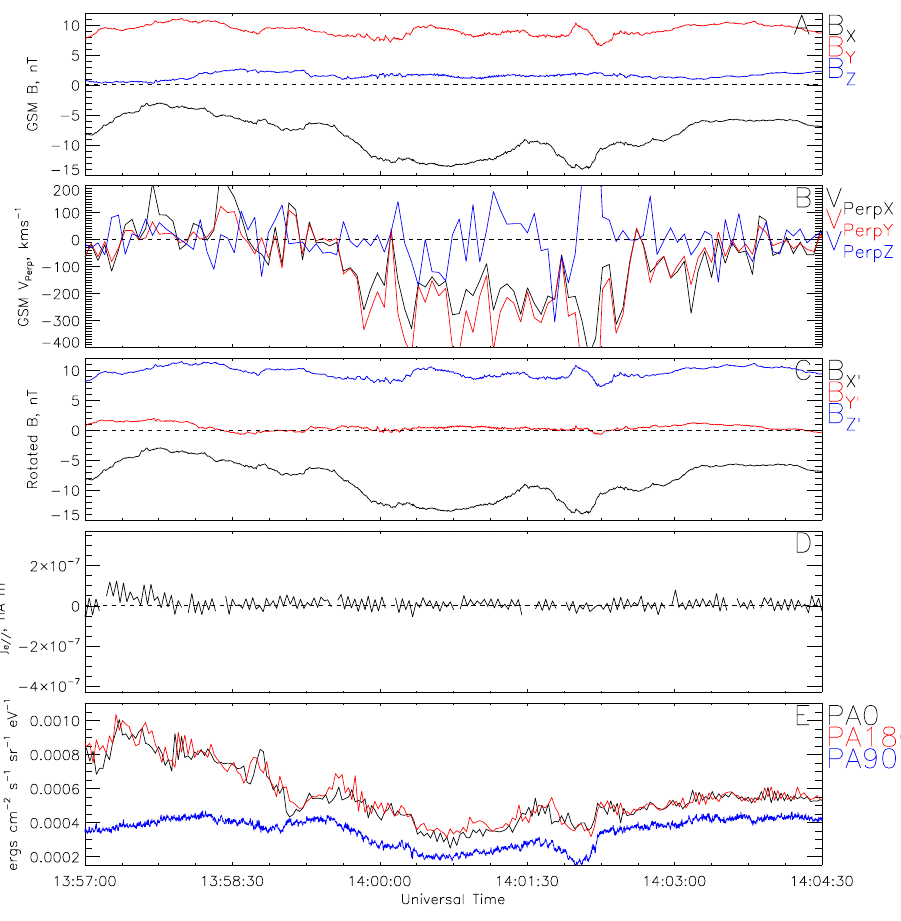
Fig. 13. A more detailed examination of the PEACE data for C2. Panel (A) shows GSM components and magnitude of magnetic field, panel (B) the GSM components of V ⊥ , panel (C) the magnetic field rotated about GSM X into a coordinate frame that eliminates any Y component in the undisturbed magnetic field, included here for completeness. Panel (D) is the parallel electron current calculated from 2-D pitch angle distributions in the energy range covered by both PEACE sensors. Panel (E) shows the electron differential energy fluxes separately for 0 ◦ PA, 180 ◦ PA and 90 ◦ PA, taken from 3-D distributions returned by both the HEEA and LEEA sensors and summed over their common energy